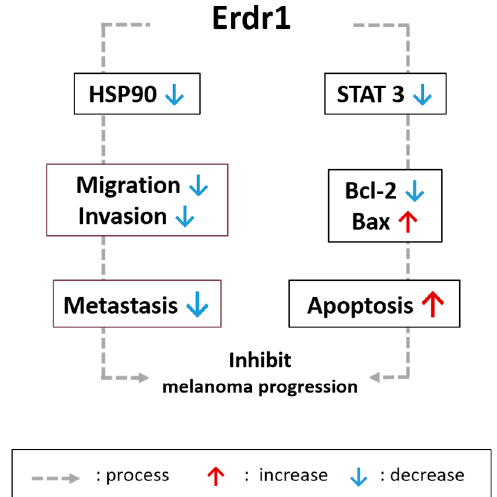
Figure 1. Erdr1 inhibits melanoma progression. Erdr1 suppresses metastasis by downregulating migration and invasion ability via HSP90 inhibition. In addition, Erdr1 reduces the apoptosis-regulating STAT3 signaling pathway. Erdr1 exerts its anti-cancerous effects by regulating HSP90 and STAT3 in melanoma.